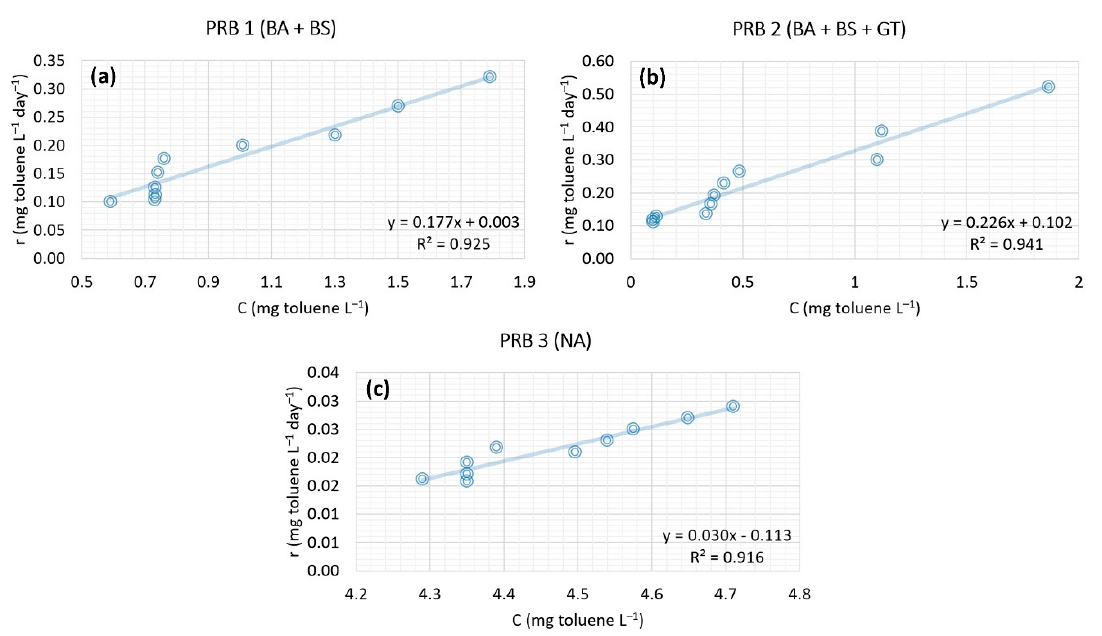
Figure 9. Reaction rate data for the PRB toluene treatment processes for phase 1: ( a ) The first-order model for PRB-1, ( b ) the first-order model for PRB-2, and ( c ) the first-order model for PRB-3.